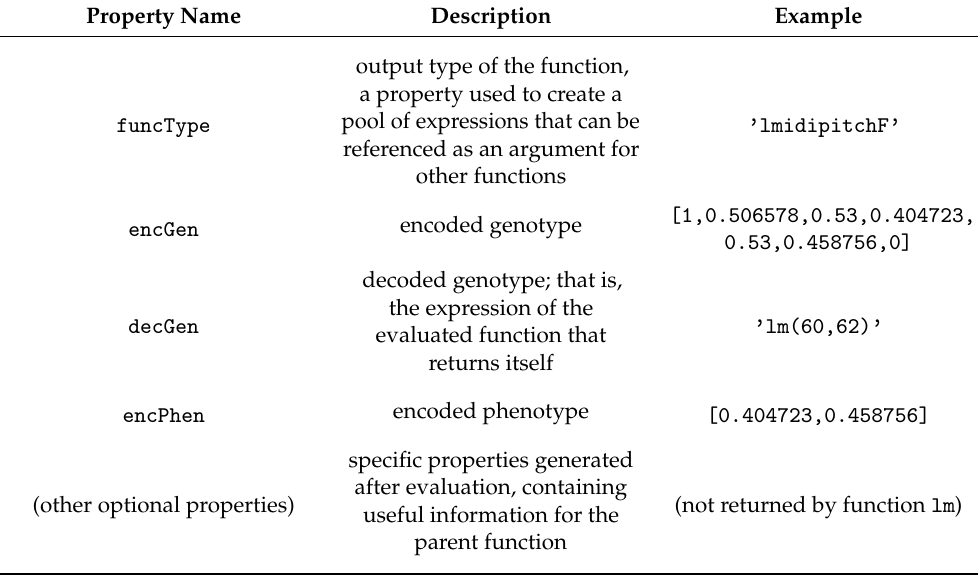
Table 1. Properties returned by a genotype function after evaluation, using as an example the expression ’lm(60,62)’ , which represents a list of two MIDI